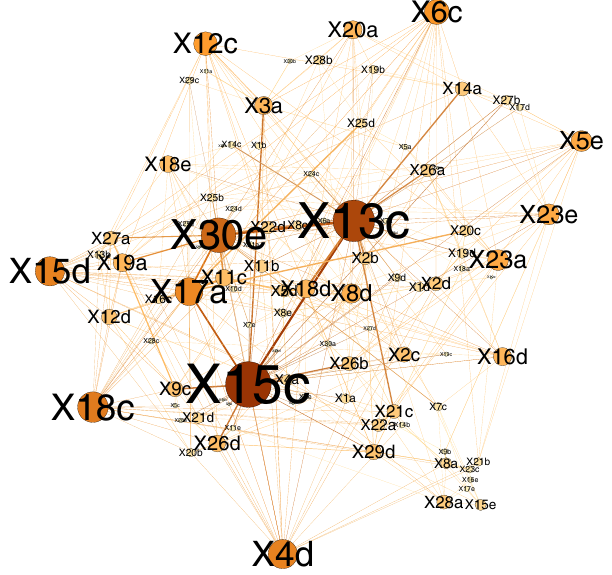
FIG. 5. The response item backbone network also contains 96 nodes but only 401 weighted connections. Node and font size represent item frequency, node color number of connections (red means more). Very infrequent nodes (small font sizes) can be viewed by zooming in on the image